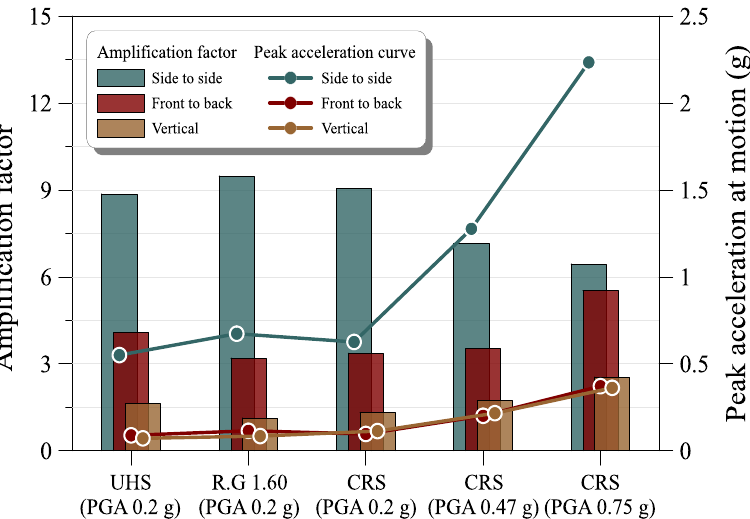
Figure 11. Relationships of amplification factor and peak acceleration depending on input motion at A6 (top of